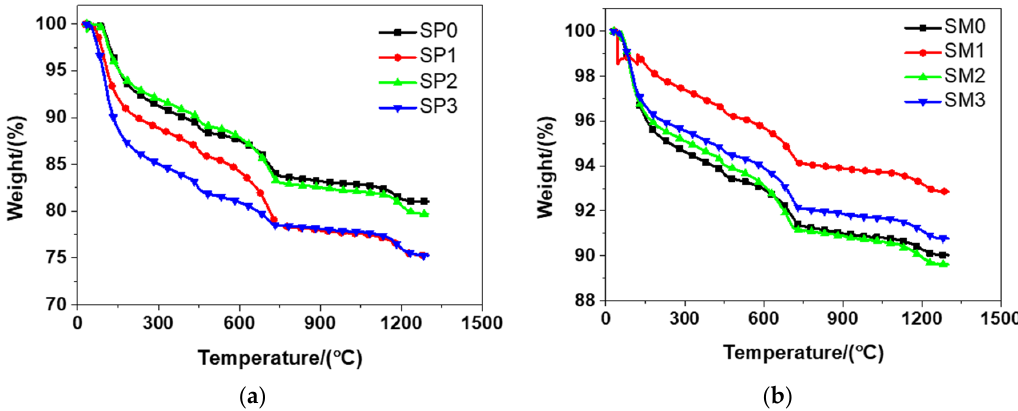
Figure 11. The thermogravimetric analysis of siliceous sacrificial cement paste and mortar: ( a ) siliceous sacrificial cement paste; ( b ) siliceous sacrificial mortar.